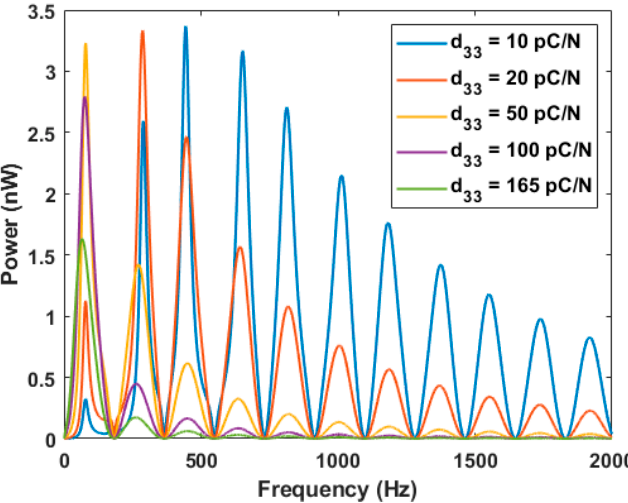
Figure 7. The projected power versus frequency for the 25% fill factor sample with various piezoe- lectric coefficients. piezoelectric